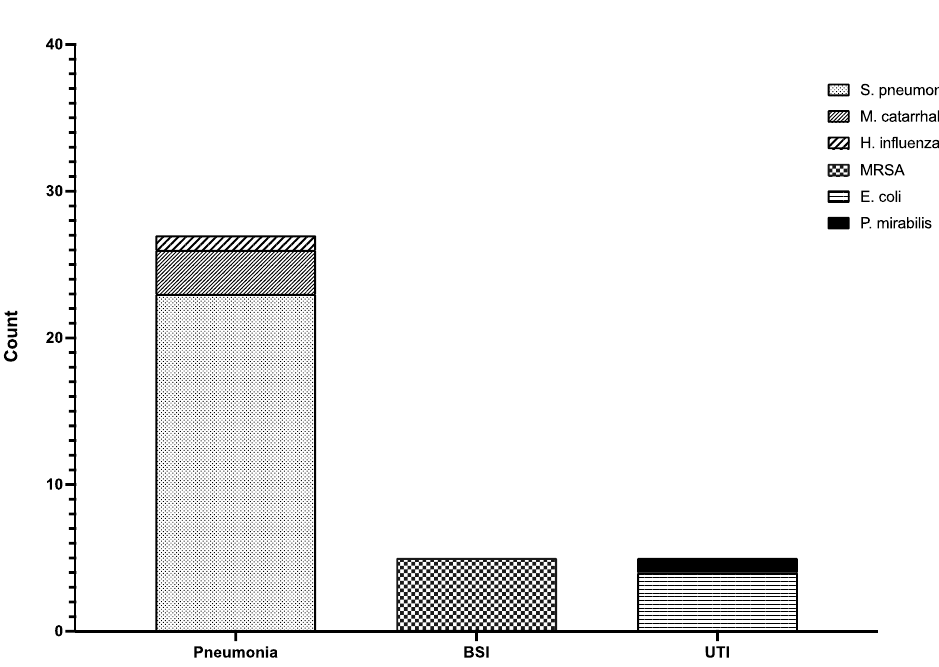
Figure 2. Etiology of CAIs by site of infection. Twenty-three cases of pneumonia were caused by Streptococcus pneumoniae (sparse points), three cases were due to Moraxella catarrhalis (thick points), and one patient had a Haemophilus influenzae (slant stripes) pneumonia. All the BSIs were caused by MRSA (checks). UTIs were caused by Escherichia coli (horizontal stripes) in four cases and Proteus mirabilis (black) in one case. Abbreviations: MRSA, methicillin-resistant S. aureus ; BSI, bloodstream infection; UTI, urinary tract infection.